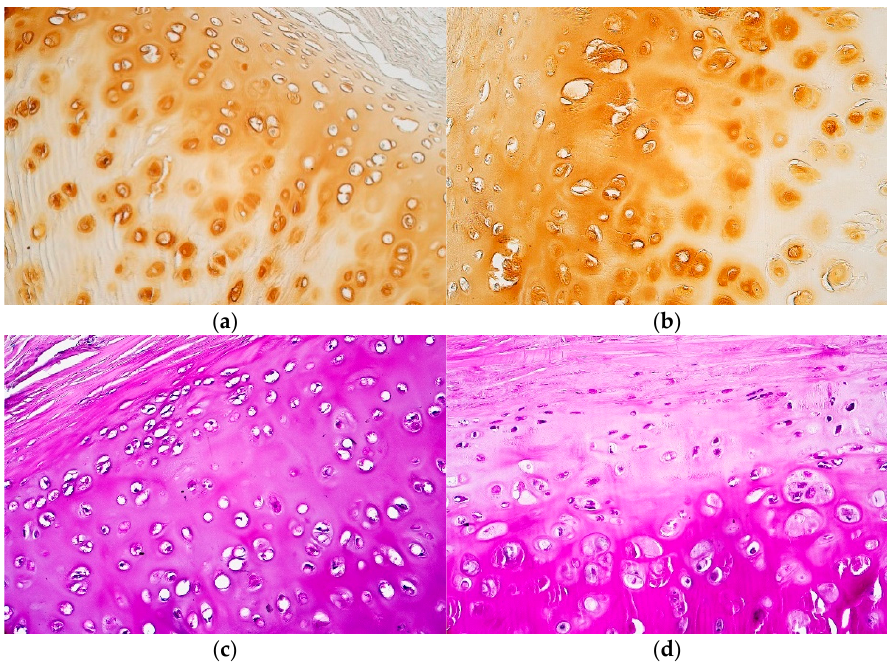
Figure 2. ( a – d ) Micrographs of tracheal hyaline cartilage stained with Bismarck brown and PAS: ( a ) Numerous positive Bismarck brown cells throughout all the zones of tracheal hyaline cartilage. Note the Bismarck brown positive extracellular matrix of proliferation and growth zones. Bismarck brown, ×200; ( b ) Note numerous positive cells across all hyaline cartilage zones together with the positive extracellular matrix in proliferation and growth zones. Bismarck brown, ×200; ( c ) Positive extracellular matrix throughout the whole hyaline cartilage. Periodic acid–Schiff, ×200; ( d ) Numerous positive cells across all of the hyaline cartilage zones. Note the intensively positive extracellular matrix in the mature cell zone. Periodic acid–Schiff, ×200. A moderate number of HBD-2 positive cells were seen in the proliferation and mature cell zones, but a moderate to numerous amount of cells was found in the growth zone of the tracheal hyaline cartilage (Table 3, Figure 3a,b).